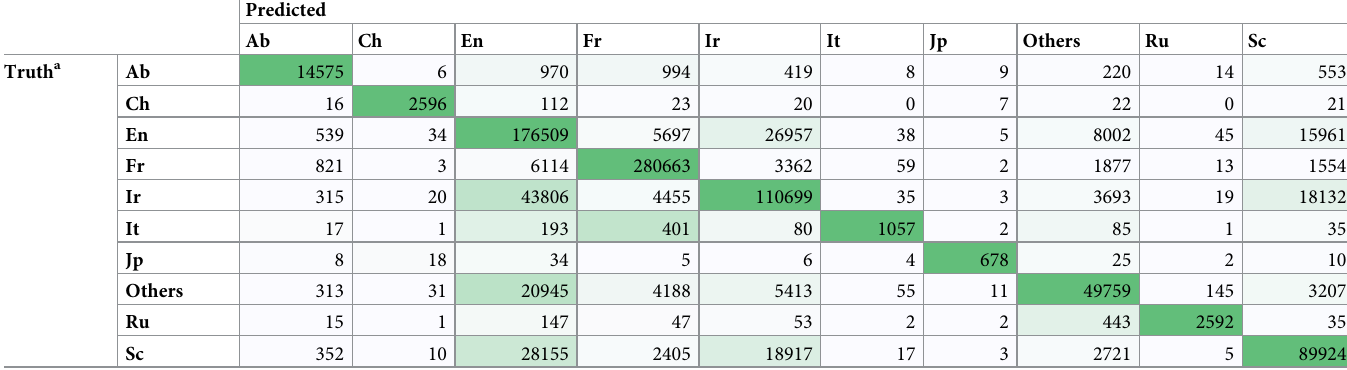
Table 4. Multiclass confusion matrix in test set for the “All name and location features” set trained in training set with regularised logistic regression classifier. Predicted